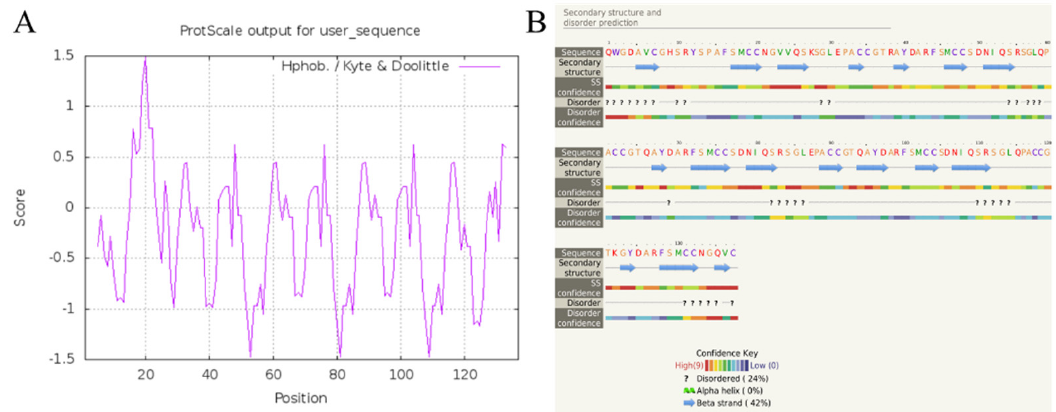
Figure 4. Hydrophobicity analysis ( A ) and secondary structure prediction ( B ) of cysrichin. Note: hydrophobicity analysis was performed by ProtScale, and secondary structure was predicted with